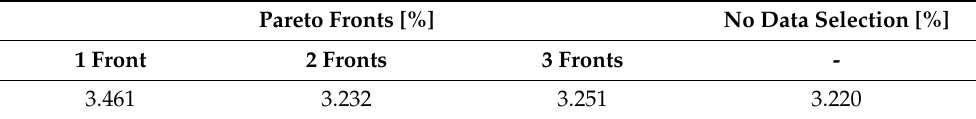
Table 10. MAPE values for Pareto fronts and ‘no data selection’ models for the fifth verification case. Pareto Fronts [%] No Data Selection